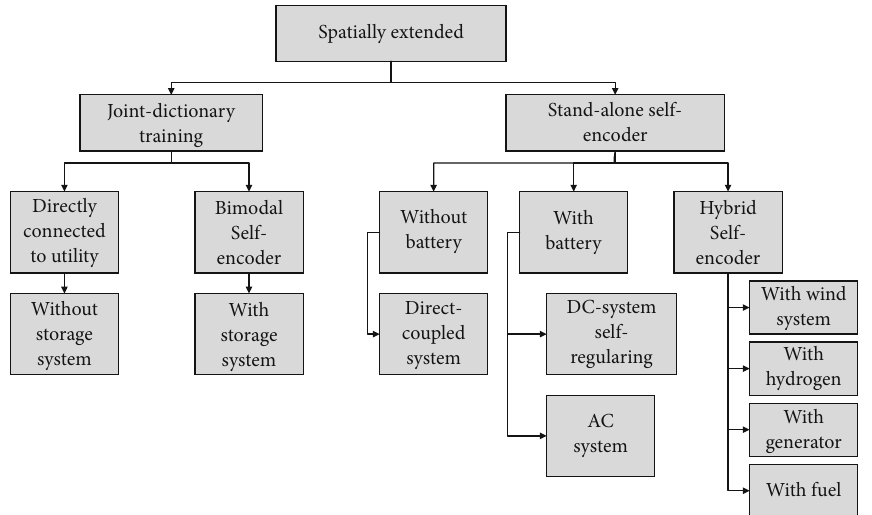
Figure 3: Flow chart of fusion